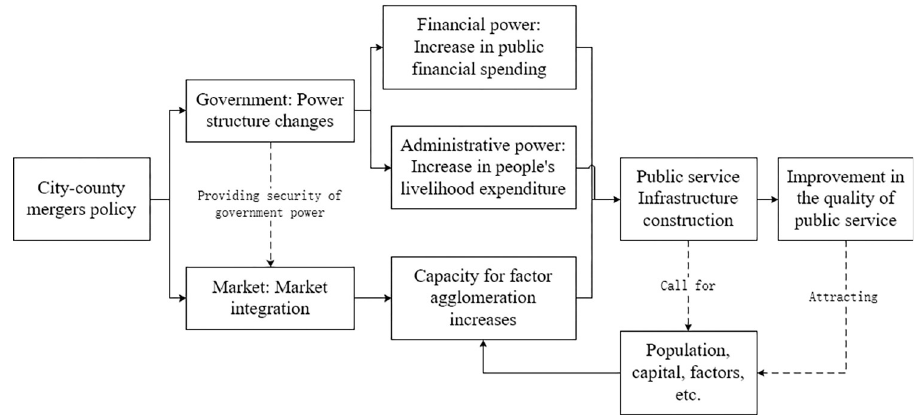
Fig 10. Transmission mechanism by which city-county mergers affect the quality of public